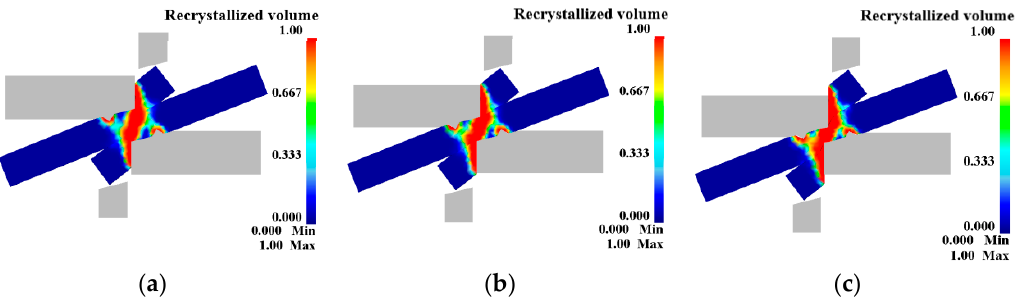
Figure 12. Dynamic recrystallization volume percentage: ( a ) L = 100%; ( b ) L = 125%; ( c ) L = 150%.